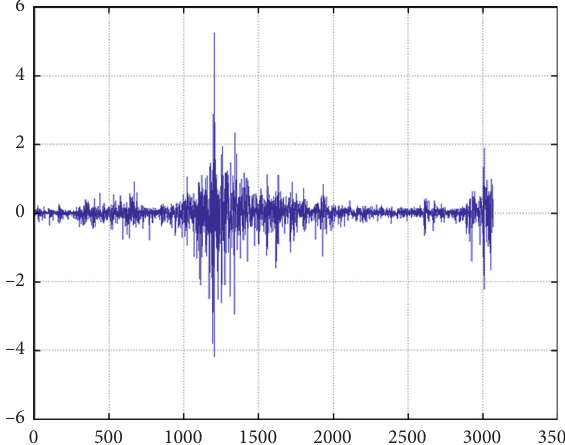
Figure 8: Elman residual plot under E 2.